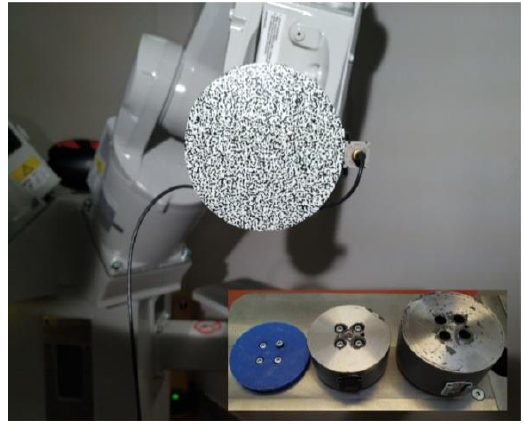
Figure 2. Robot payload with applied black-and-white speckle pattern.